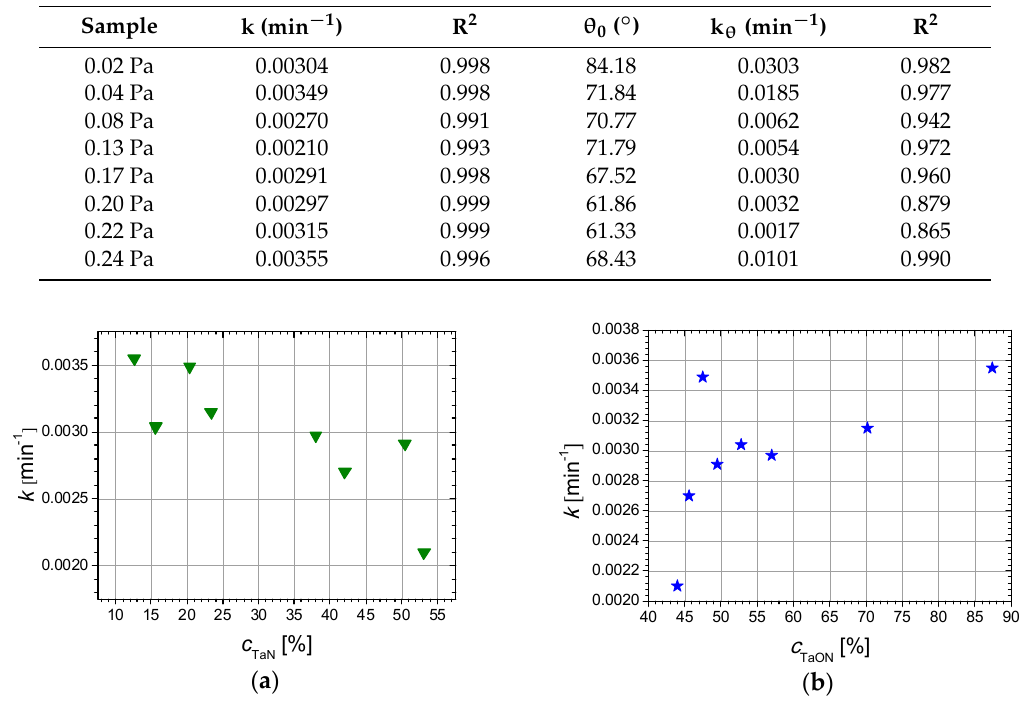
Figure 13. ( a ) Variation of the rate constant, k , of MB, with the concentration of TaN and ( b ) TaO x N y phases in the films, detected by XPS.